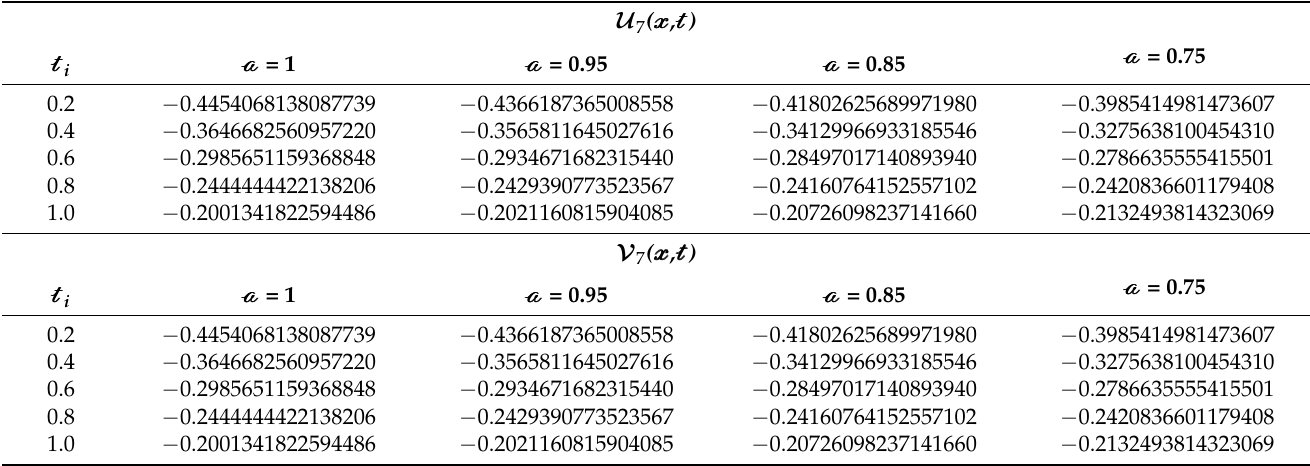
Table 5. Numerical results of approximated solutions, at n = 7, 𝓍 = 10, and different values of 𝒶 , for Example 2.